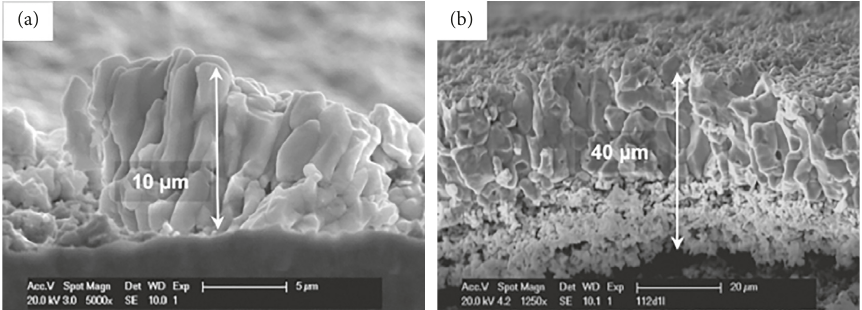
Figure 3: Micrographs of an AgCl layer, deposited at different current densities: (a) cross section of sensor A at 0.5mA/cm 2 ; (b) cross section of sensor D at 4mA/cm 2 .